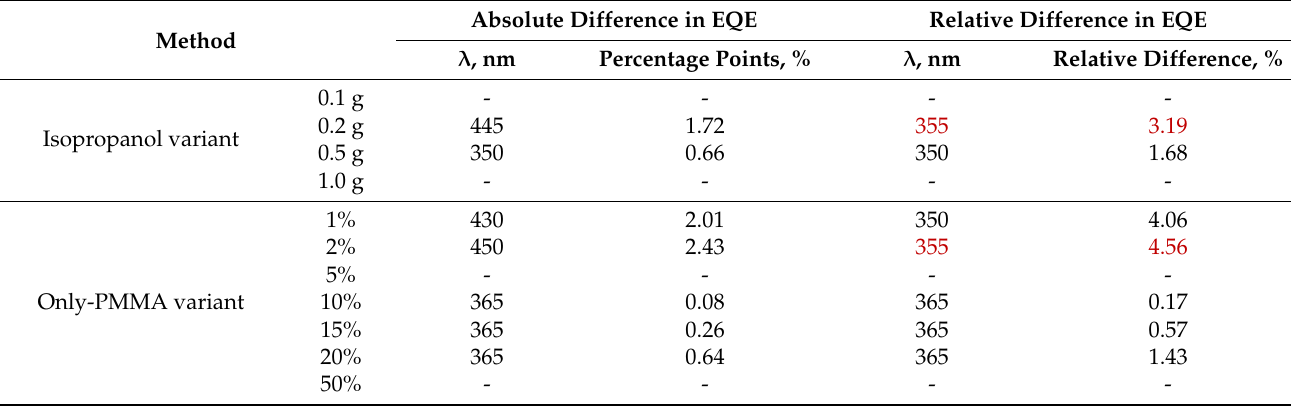
Table 1. The most important points for EQE characteristic for two variants of deposition for pigments BGL. Method